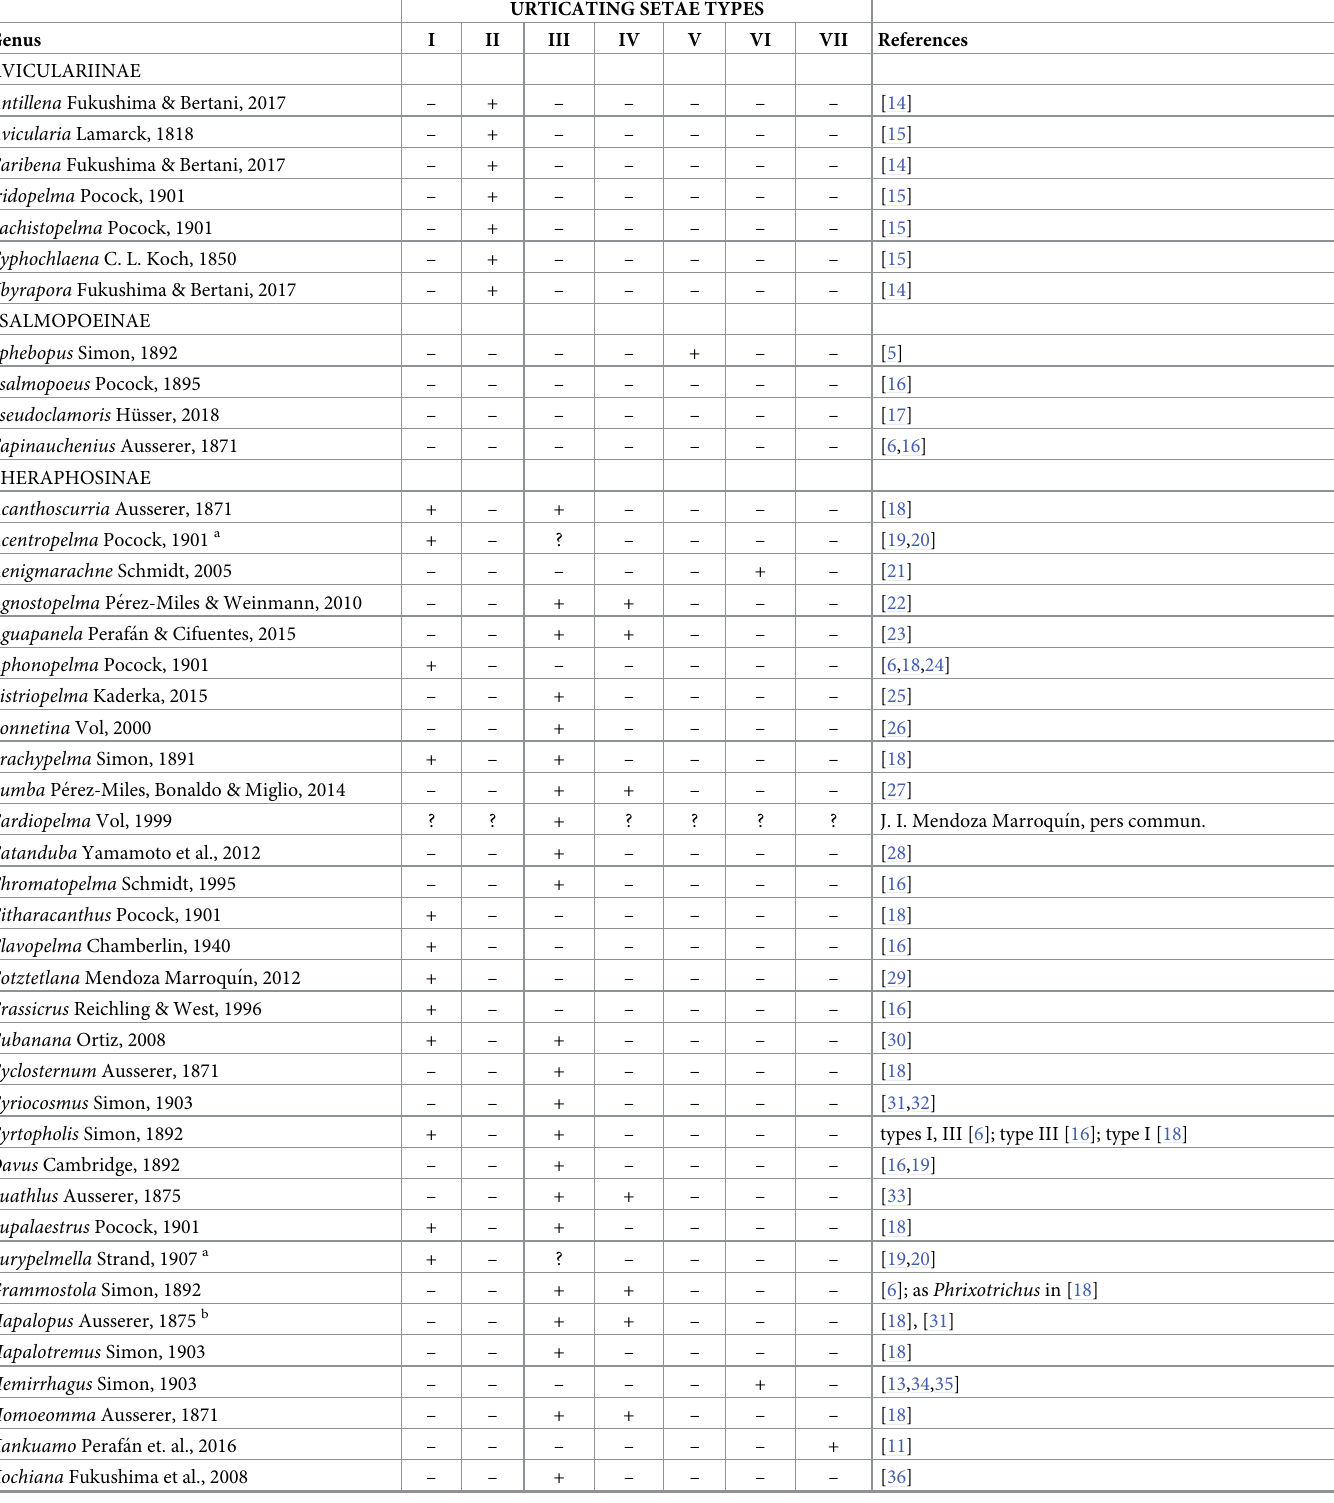
Table 1. Distribution of urticating setae types according to the previously published papers or unpublished